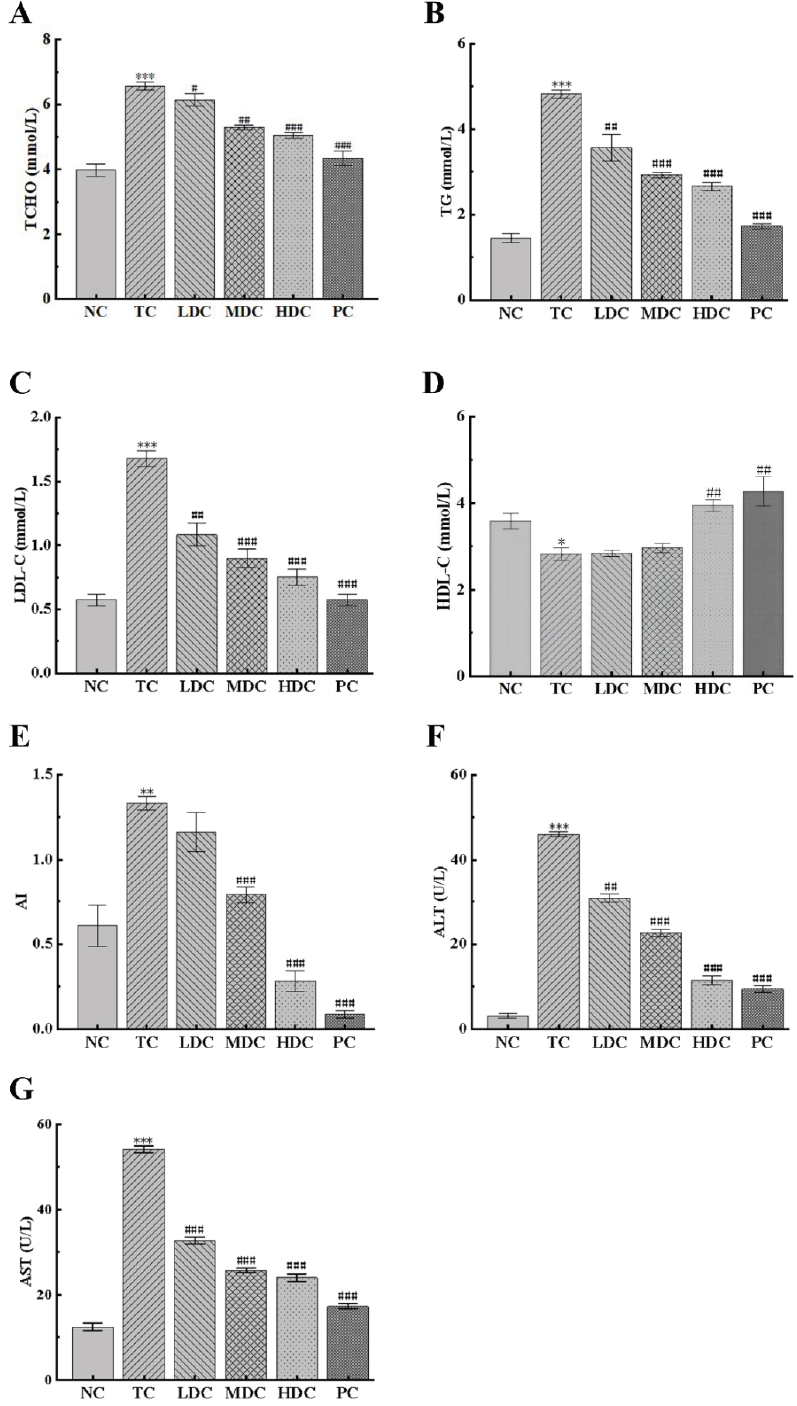
Figure 2. Effect of PSS on general biochemical indicators. The content of ( A ) total cholesterol